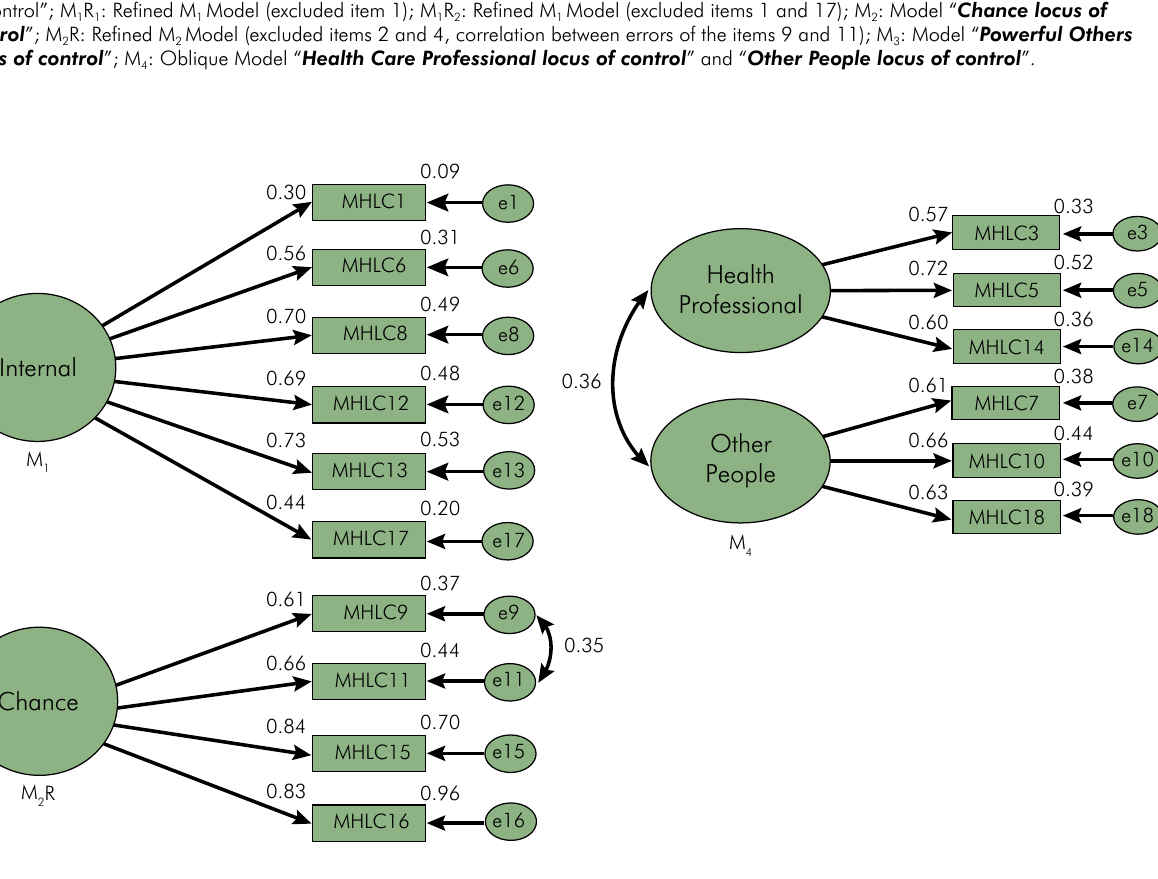
Figure. The multidimensional health locus of control scale – Form C (MHLC-C) fit to the